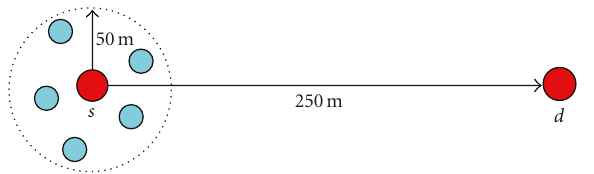
Figure 11: Topology example of the cooperative network.